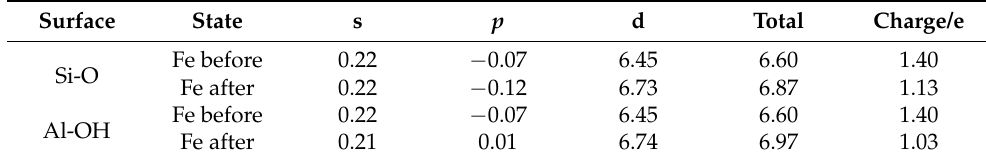
Table 4. Mulliken charge of Fe, respectively, on Si-O and Al-OH surface.